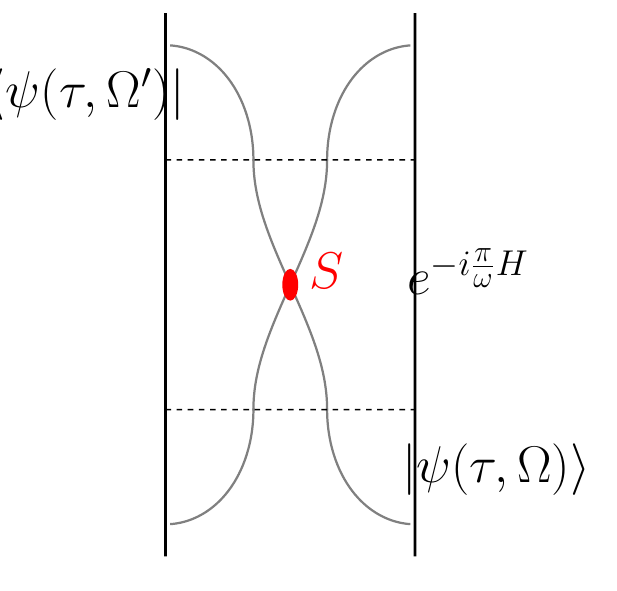
Figure 4 . A cartoon interpreting the scattering correlation function G scat ( E, θ ) defined in (5.32). The bottom and top pieces indicate Euclidean semi-infinite cylinders with local operator insertions, preparing initial and final states | ψ ( τ, Ω) i , | ψ ( τ, Ω 0 ) i . These states have coherent wavefunctions of zero average momentum on the times indicated by the dashed lines. The middle section denotes a piece of Lorentzian AdS, giving evolution by real time π . The particles are accelerated by the ω AdS potential, scatter in the region S , and then decelerate back to rest. The resulting correlator is proportional to the scattering